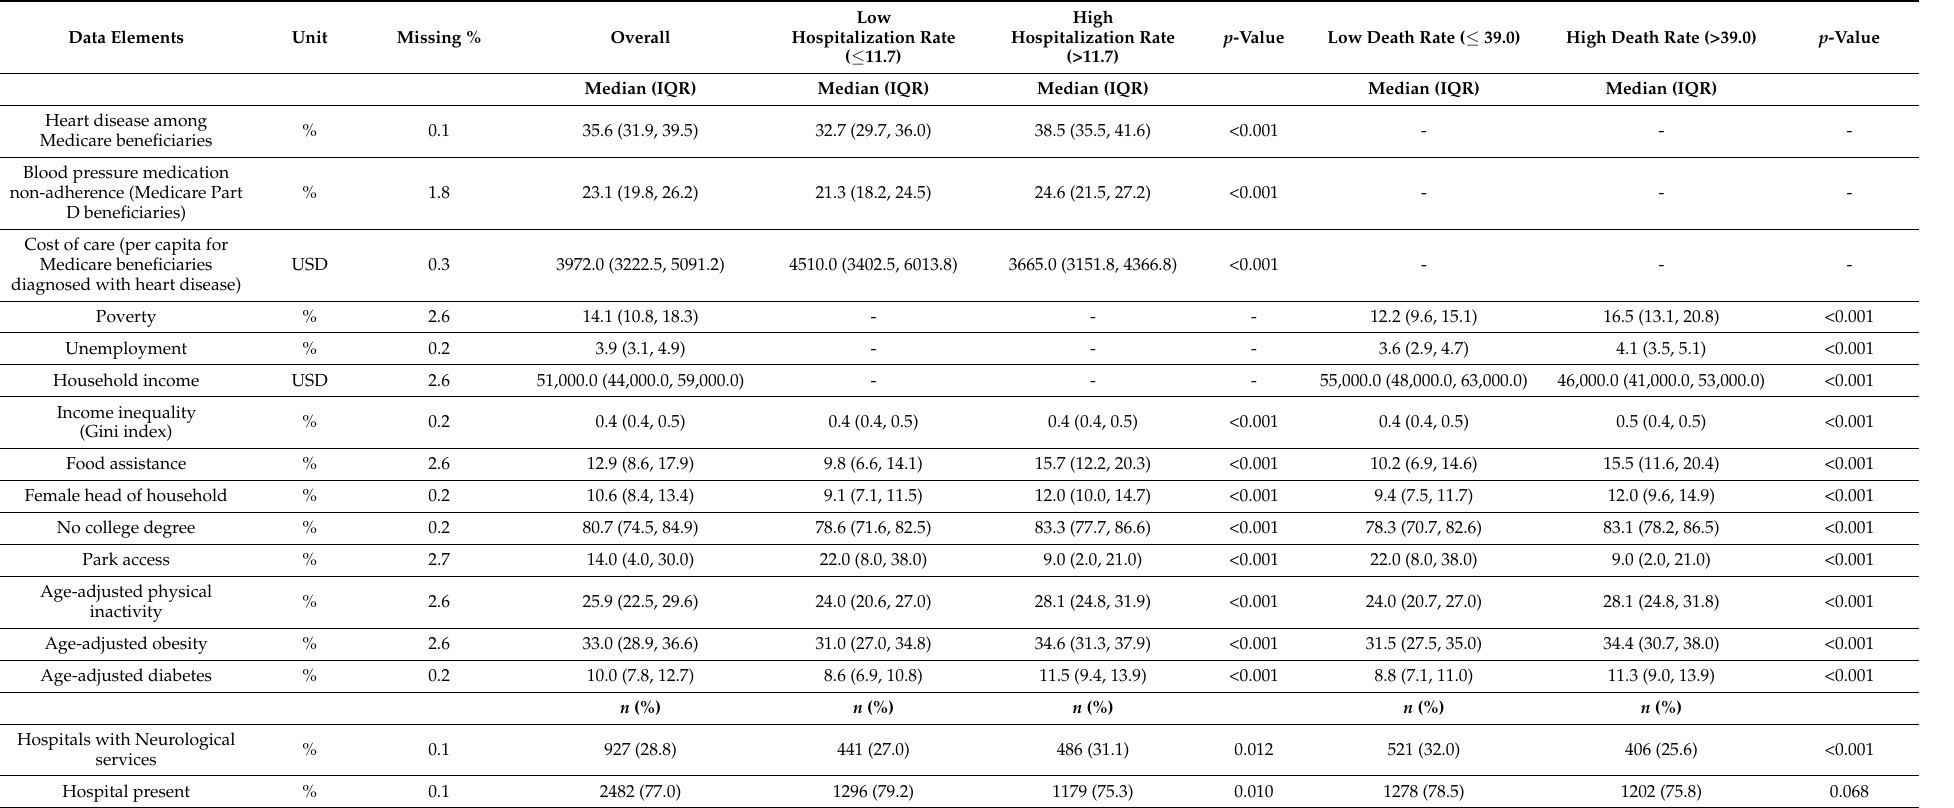
Table 1. Comparison between counties/county-equivalents of the states and territories in the US with lower and higher stroke hospitalization rate (SHR) and stroke death rate